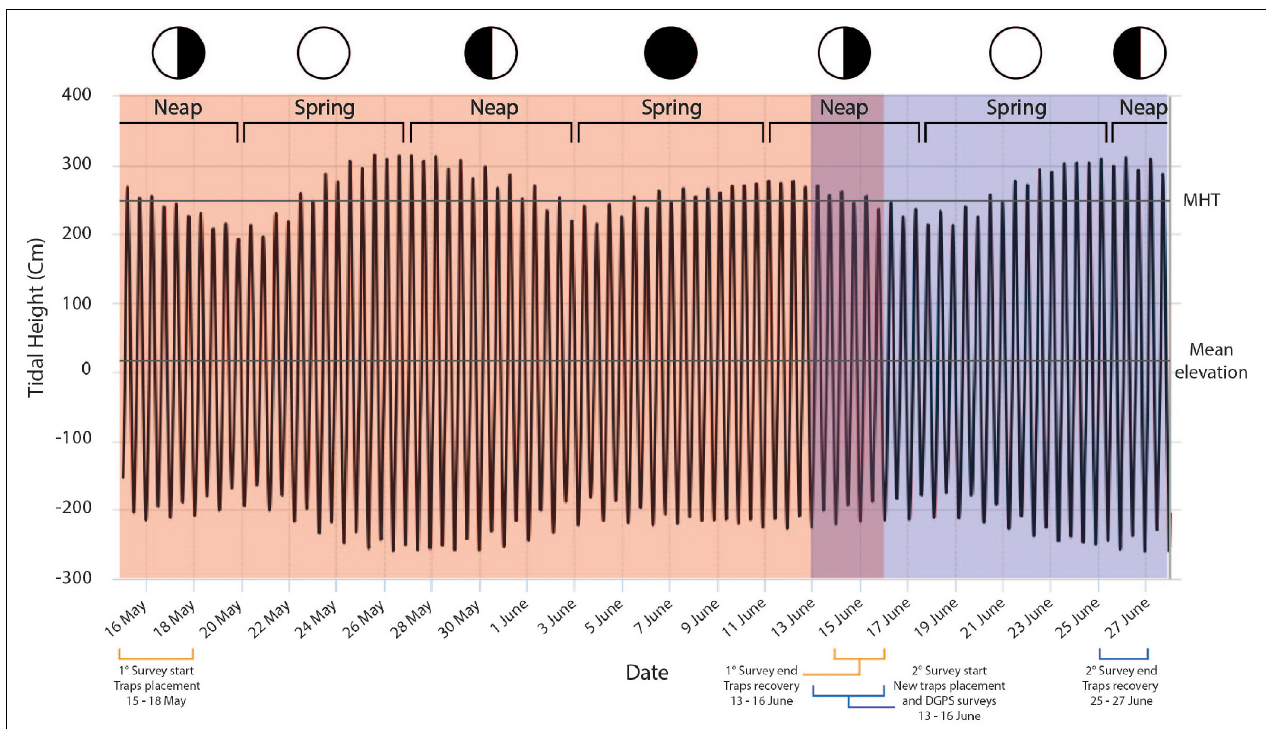
FIGURE 4 | Neap and Spring tides during the experiments. The first experiment is from 15 of May to 16 of June; the second experiment is from 13 to 27 of June. Data from the tidal station of Walsoorden. The “Mean Elevation” horizontal line marks the mean elevation of the tidal flat.